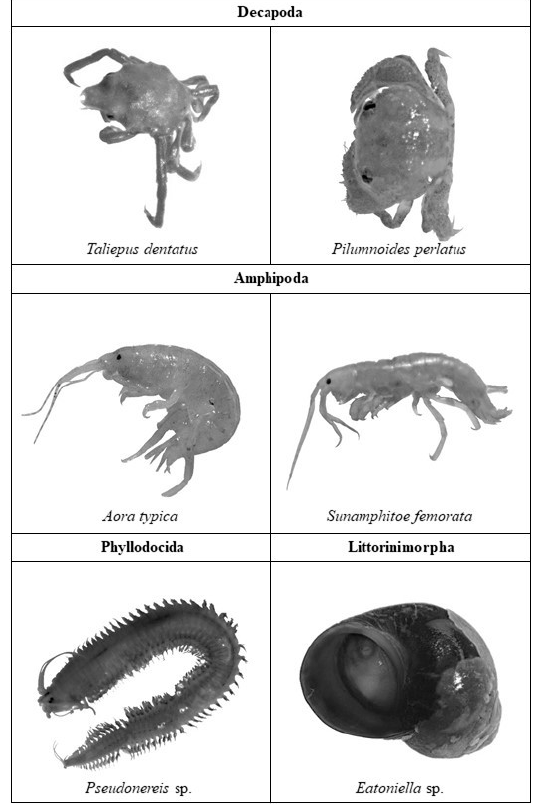
Figure 3. Representative images of the identified species associated with Macrocystis pyrifera thallus.